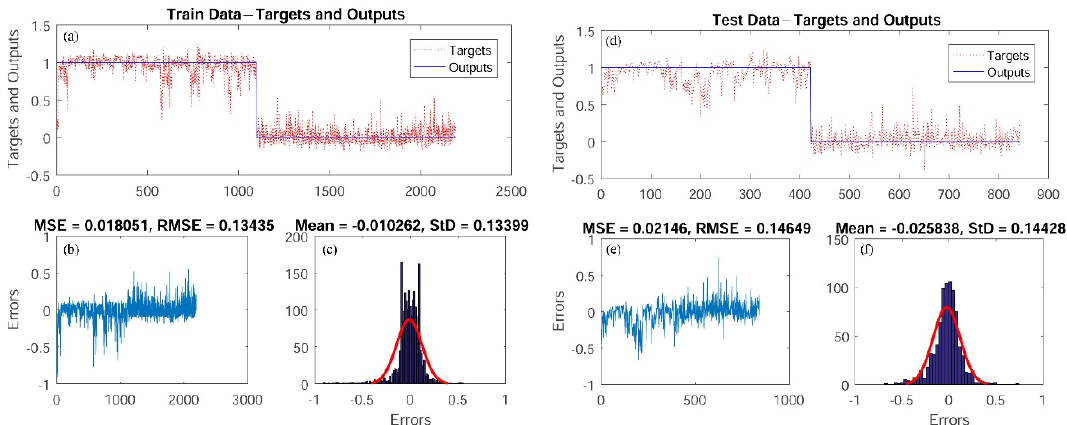
Figure 8. SVR-GWO model: ( a ) target and output SVR-GWO value of training data samples, ( b ) MSE and RMSE value of training data samples, ( c ) frequency errors of training data samples, ( d ) target and output SVR-GWO value of testing data samples, ( e ) MSE and RMSE value of testing data samples, ( f ) frequency errors of testing data samples.